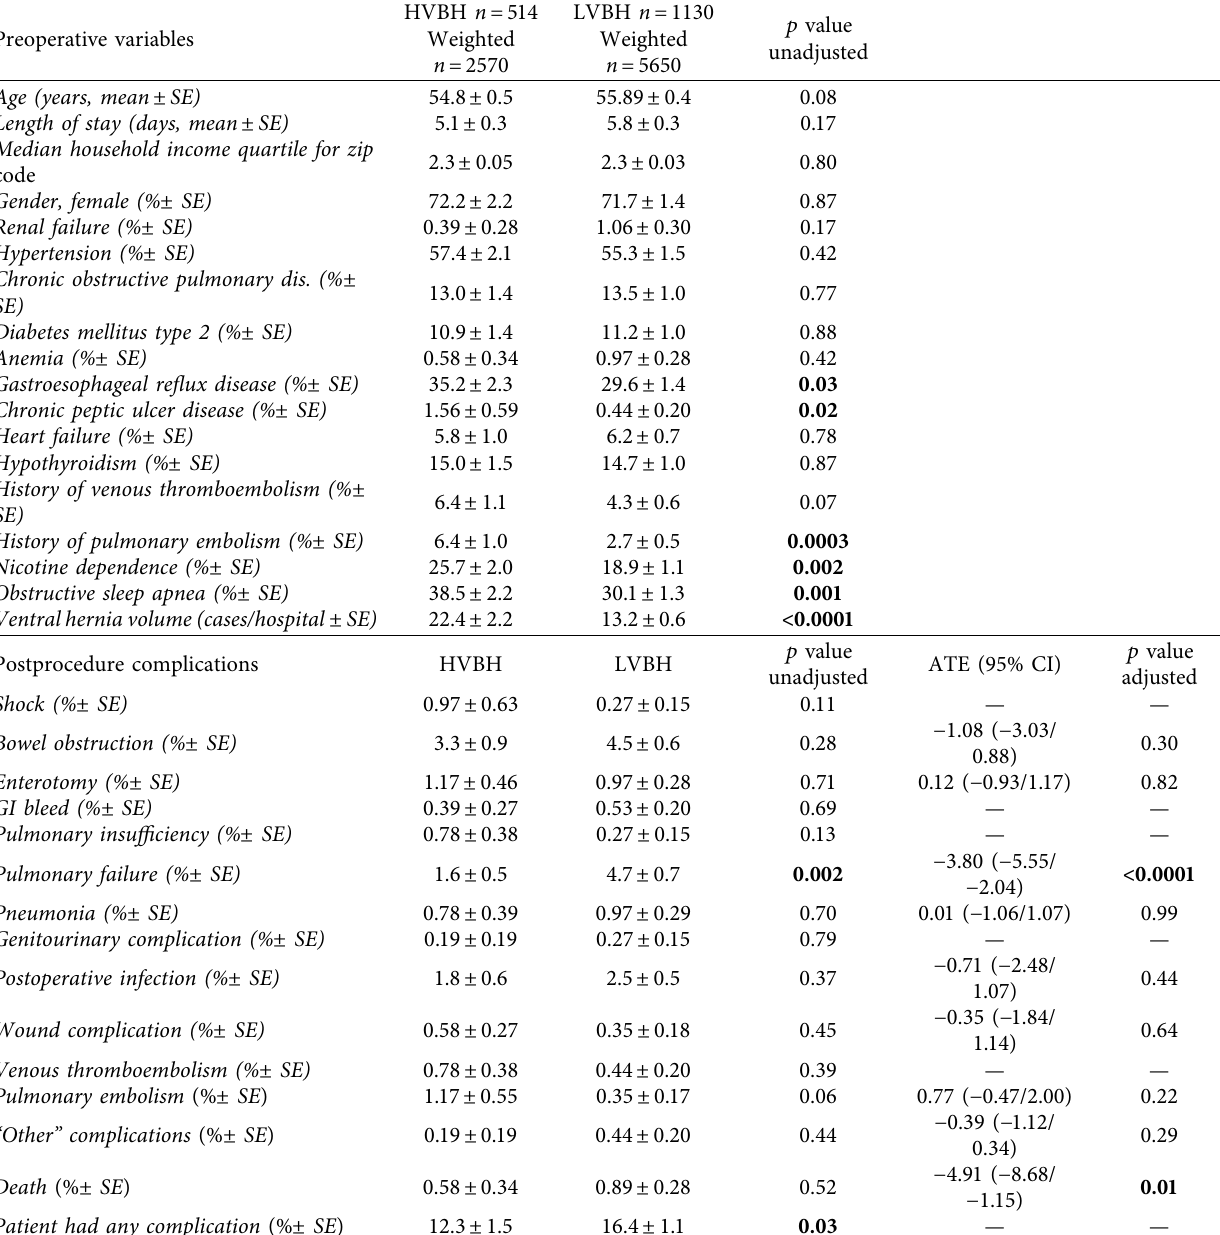
Table 4: Preoperative comorbidities and postoperative complications of patients with morbid obesity undergoing elective ventral hernia